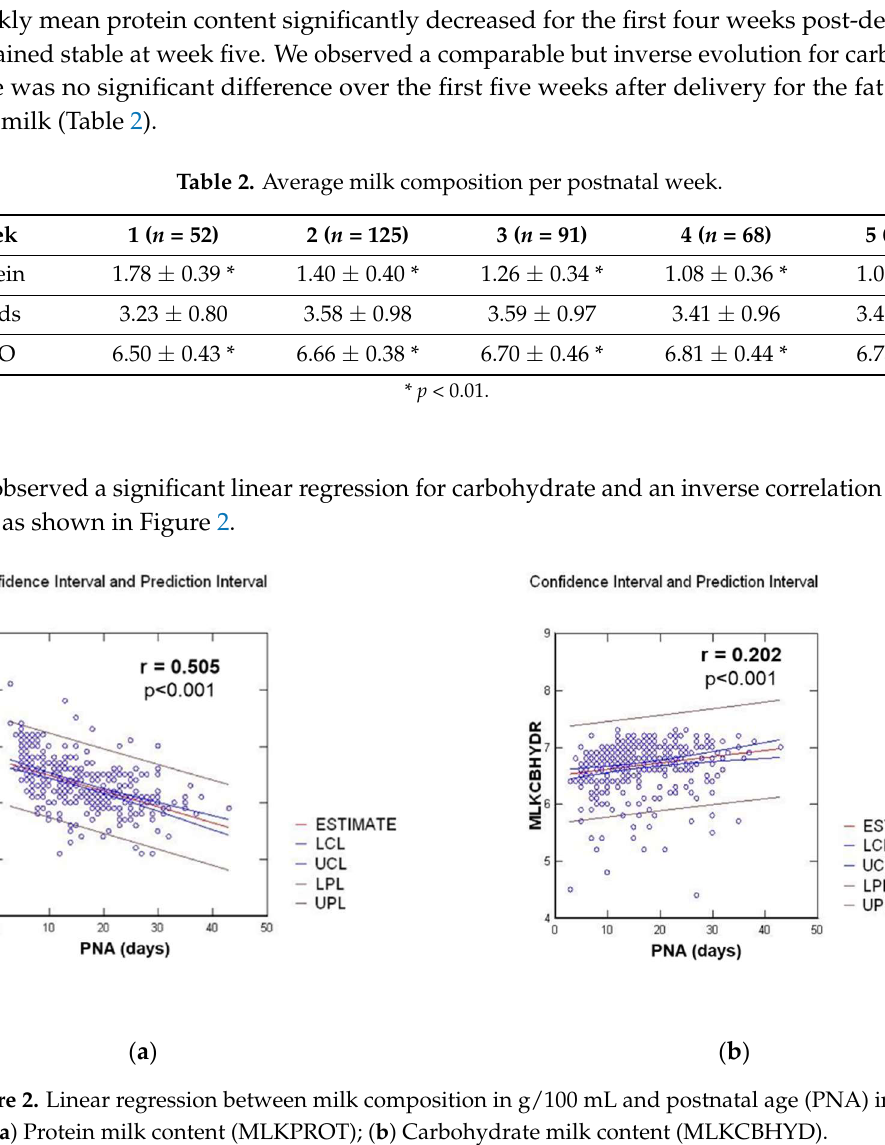
Table 3. Confounding perinatal factors for milk composition.